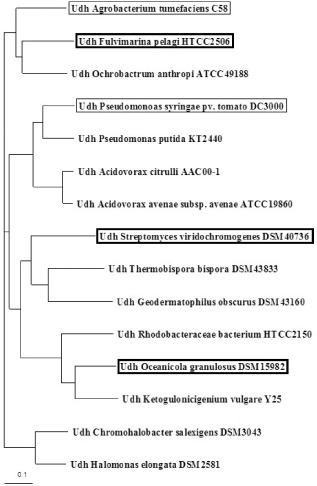
Phylogenetic tree of investigated uronate dehydrogenases and putative enzymes identified through blast. The two reference enzymes are thin framed, and the three investigated enzymes are thick-framed. The alignment was calculated with clustalw2, and for visualization the program treeview was used.